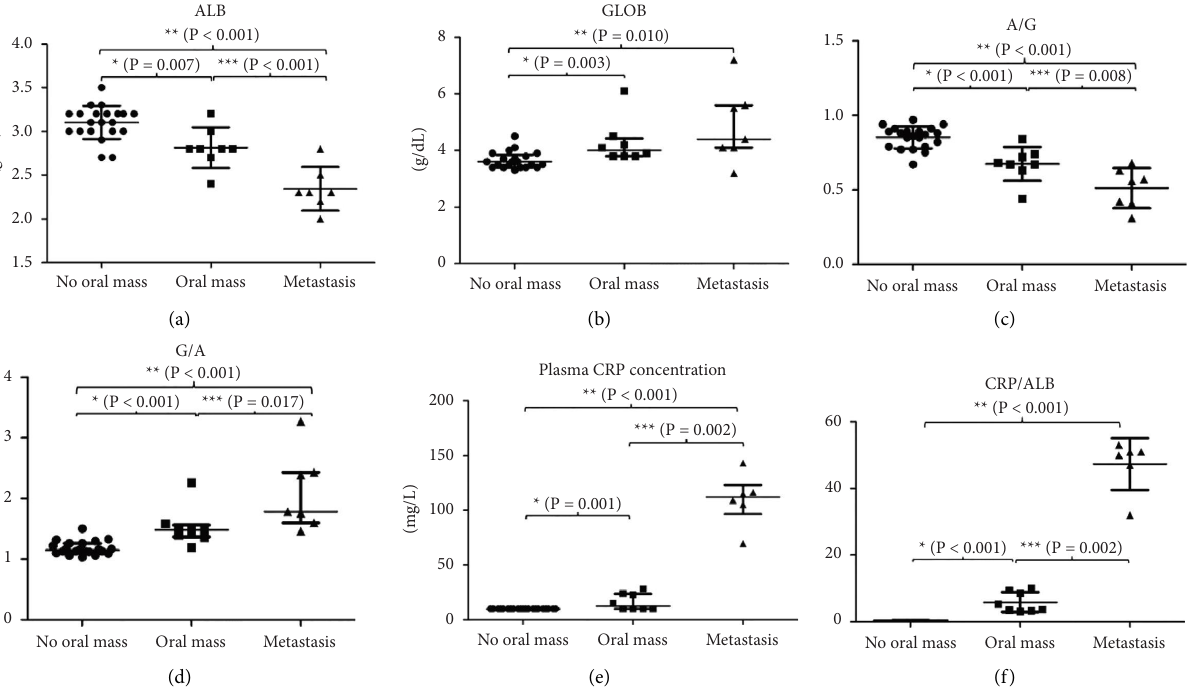
0.001)** * (P = 0.007) *** (P <